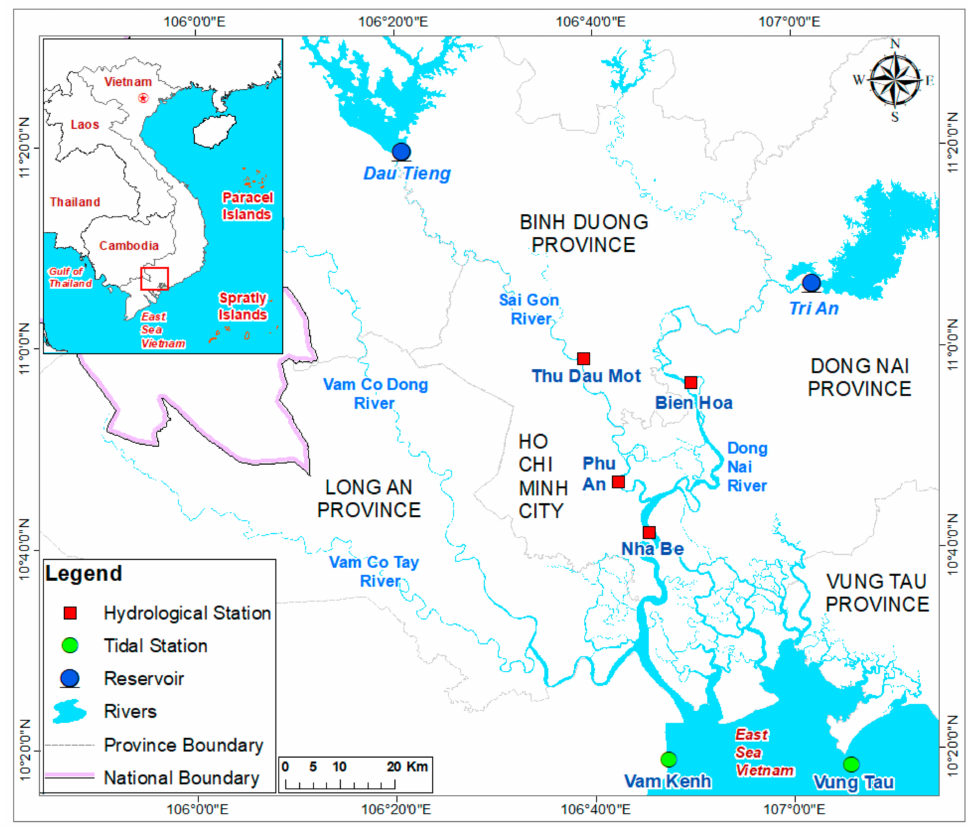
Figure 1. The study area and the location of the six gauging stations that were investigated. Rainfall is unevenly distributed on an annual and monthly basis; the rainy season lasts from May to October annually and that accounts for 85% of total annual rainfall. The average annual rainfall at Nha Be monitoring station is approximately 1500 mm, while approximately 1850 mm is measured at Tan Son Nhat station. The annual average temperature ranges from 27 ◦ C to 29 ◦ C. The average temperature difference between the months of the year ranges from 2 ◦ C to 5 ◦ C. December has the lowest average temperature and April has the highest average temperature. The average wind speed varies from 2 to 3 m/s depending on the month and year, with the southeast direction (in January–April) and the southwest direction (in July-December). The yearly average humidity is 76%, with higher humidity in the rainy than the dry season. From July through